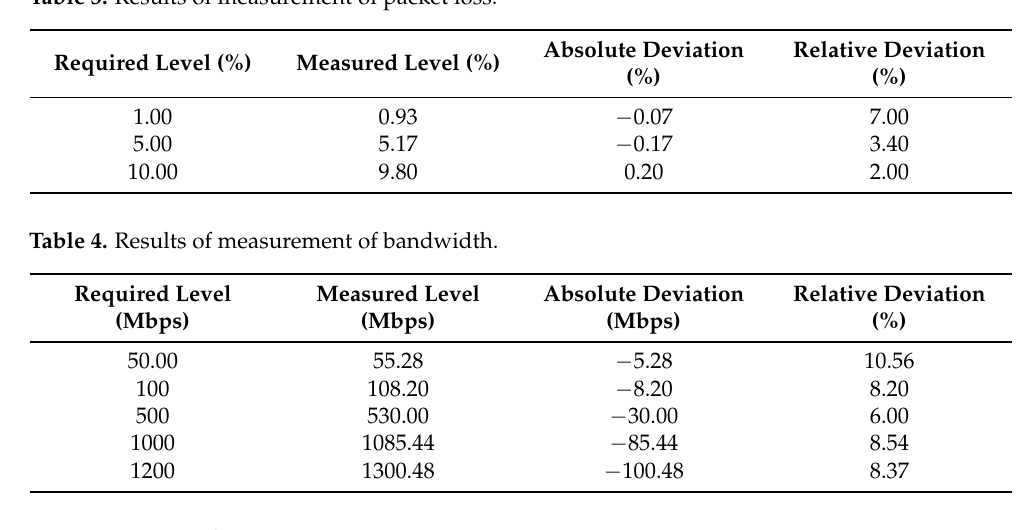
Table 3. Results of measurement of packet loss.